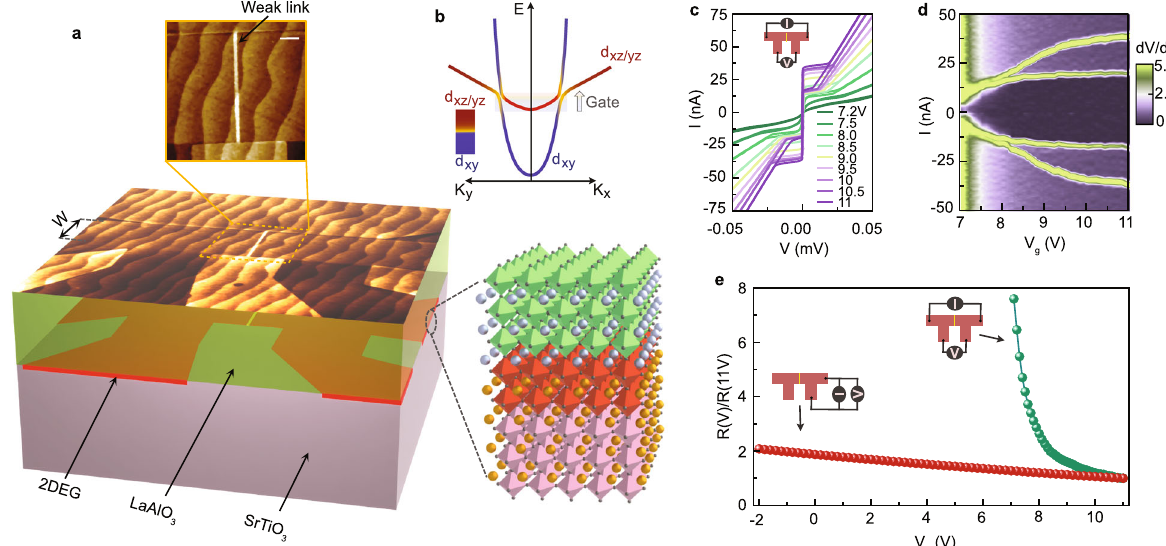
Fig. 1 Device geometry and characterization. a Schematic of the LaAlO 3 /SrTiO 3 device fabricated using double-step electron-beam lithography and low energy Ar + ion irradiation. The upper surface of the schematic represents the actual atomic force microscopy topographic scan of the device. The dark red region represents the conducting interface, while the light (pink) area corresponds to the insulating interface. The W ~ 1 μ m (here) denotes the width of the conducting channel. The upper panel shows a magni fi ed view of the weak link region in the middle of the device with a weak link length L ~ 35 nm. Scale bar, 200 nm. The right panel shows a schematic of the crystal structure of the LaAlO 3 /SrTiO 3 heterointerface. b Sketch of the band structure of the 2DEG, adapted from ref. 10 . c Current I vs voltage V traces at different gate voltage V g measured at 20 mK in a four-probe con fi guration. d Gate voltage-dependent color plot of dV / dI . e Normalized resistance vs gate voltage curves obtained from the fi tting of the linear region of I – V curves measured in two different geometries presented in the inset. The green curve is the measured resistance using a four-probe method where current fl ows through the weak link, while red data are obtained in a two-probe con fi guration where the weak link is